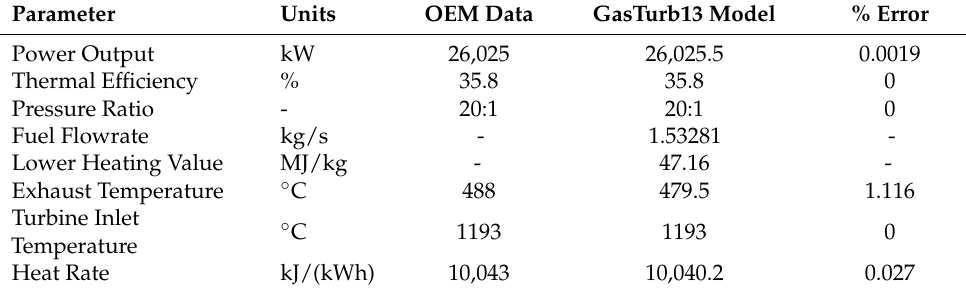
Table 5. Comparison of the design point model output with OEM catalogue